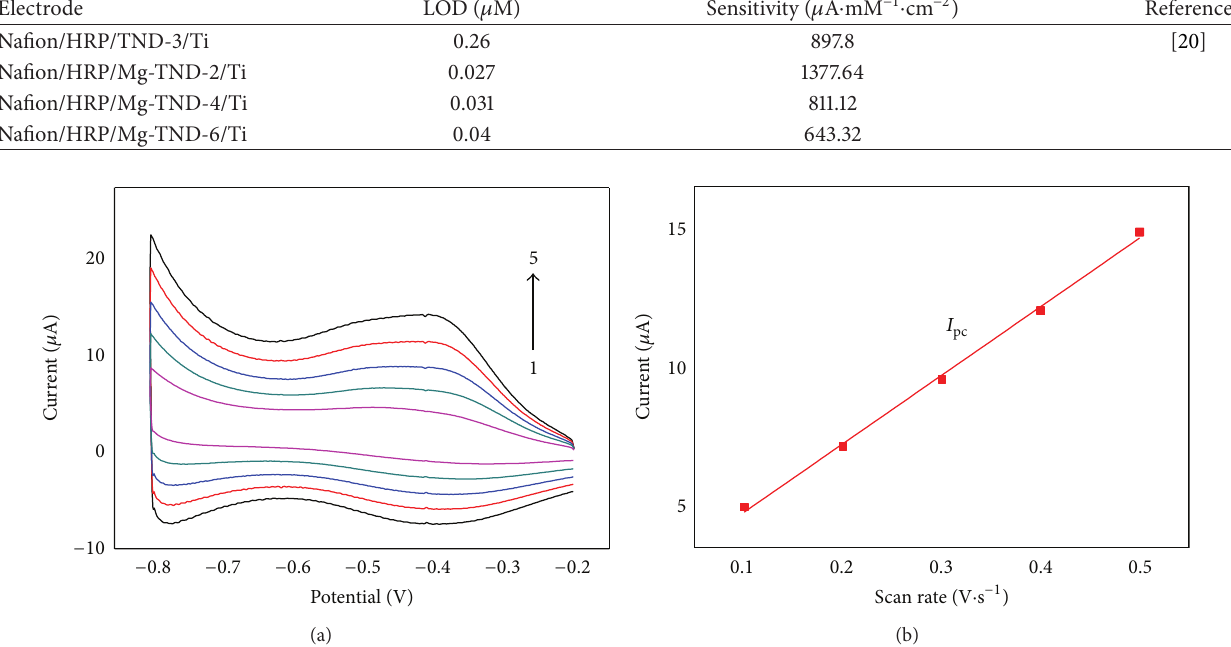
Table 3: The specific parameters of the four biosensor electrodes.